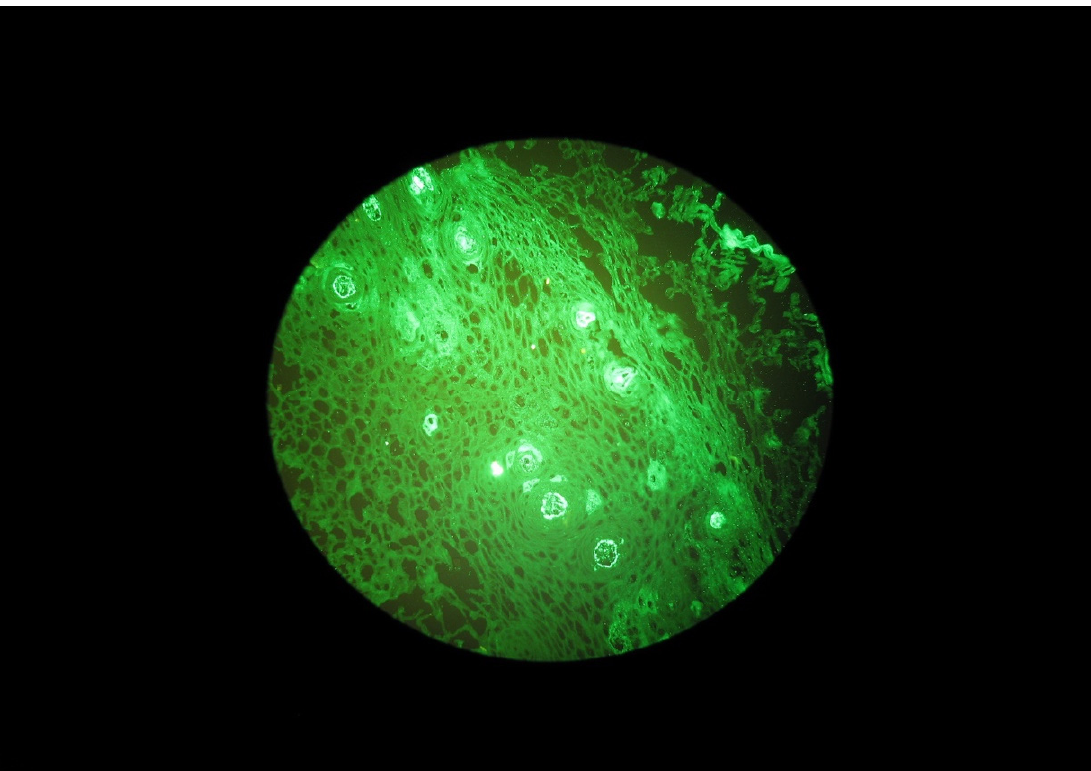
Figure 2. Granular IgA deposits beneath the basal membrane of the oral mucosa in a DH patient.